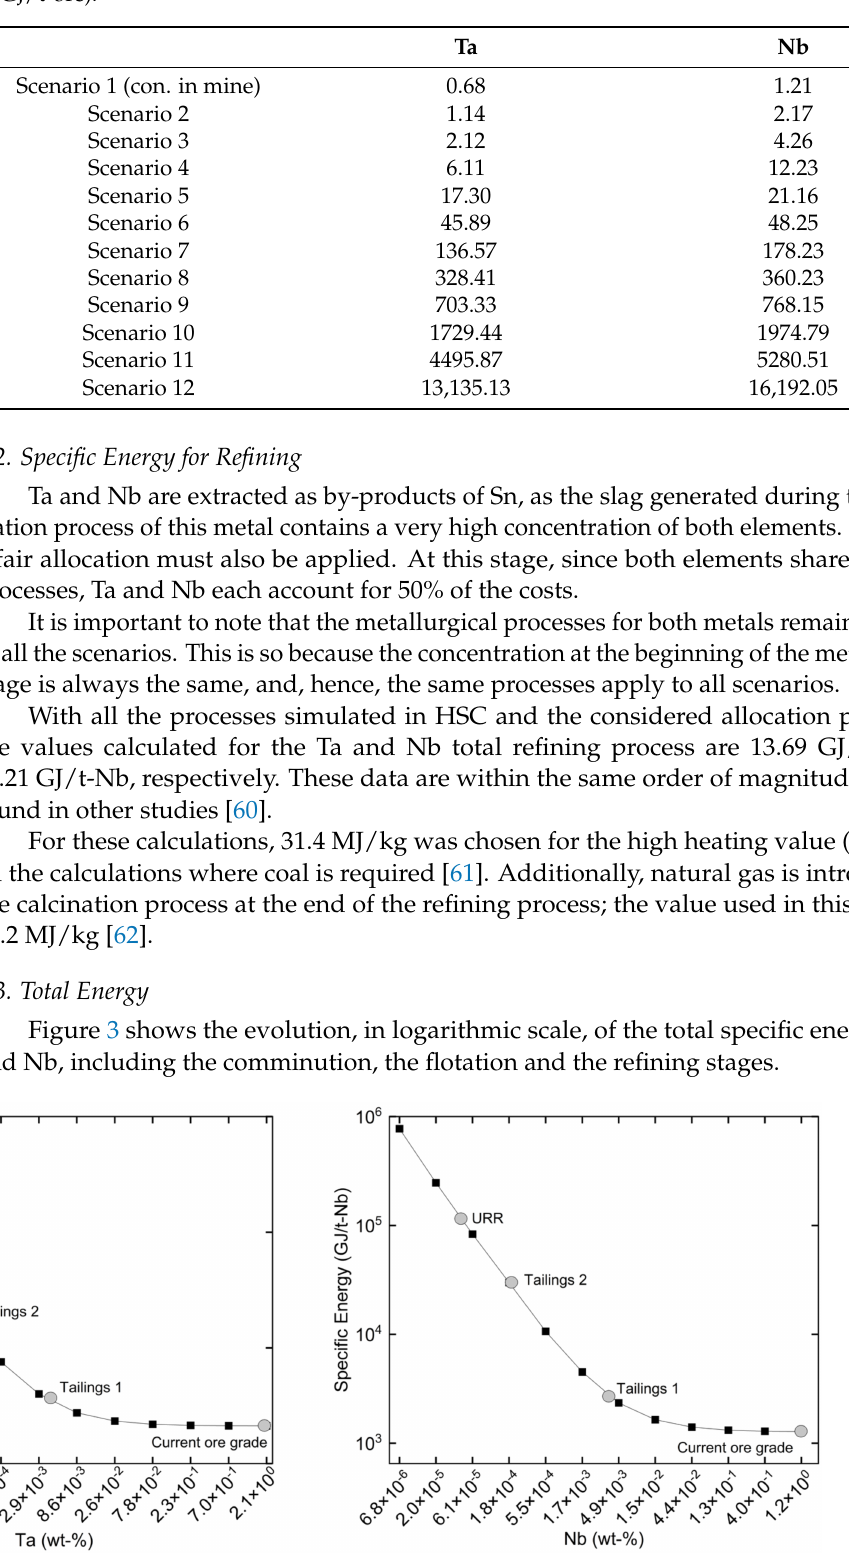
Table 6. Evolution of the specific energy for concentration obtained during the flotation stage (data in GJ/t-ore).